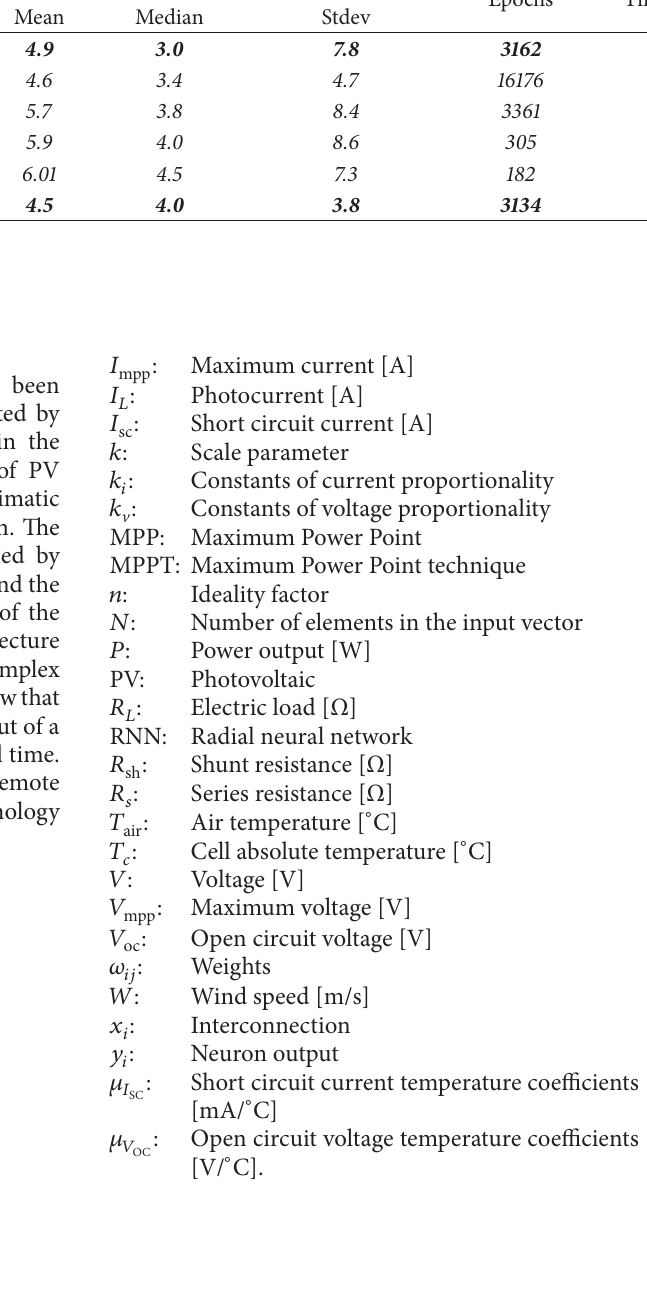
Table 6: ANNs results for the Sanyo panel; bold identifies the ANNs with the best performance. Error distribution [W] Absolute error distribution Topology